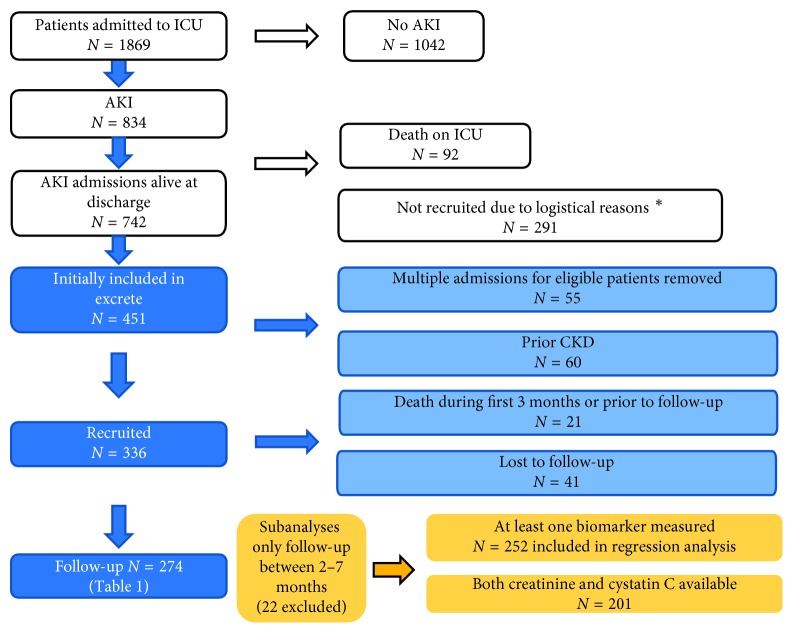
Flow chart showing selection and exclusion of patients in the follow-up cohort. White boxes: entire ICU cohort, information derived from cross-matching with the ICU database and death register; blue boxes: data from the initial study database; yellow boxes: details of groups included in subanalyses. ∗Patients discharged when research staff were not working or who were transferred to other hospitals were not recruited.